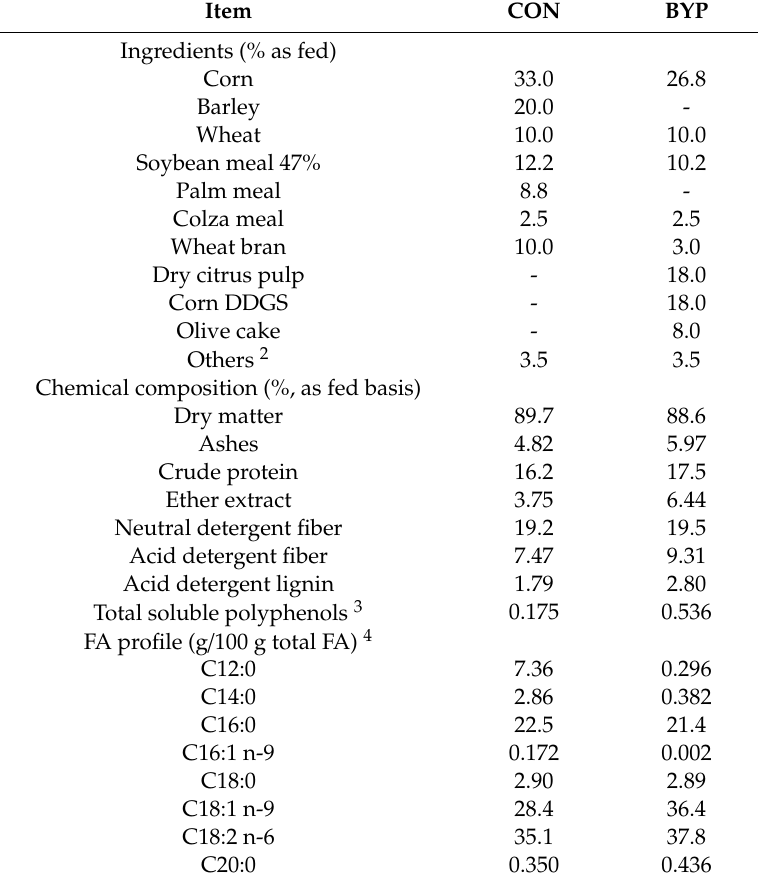
Table 1. Ingredients, chemical composition, and fatty acid (FA) profiles of experimental concentrates 1 . Item